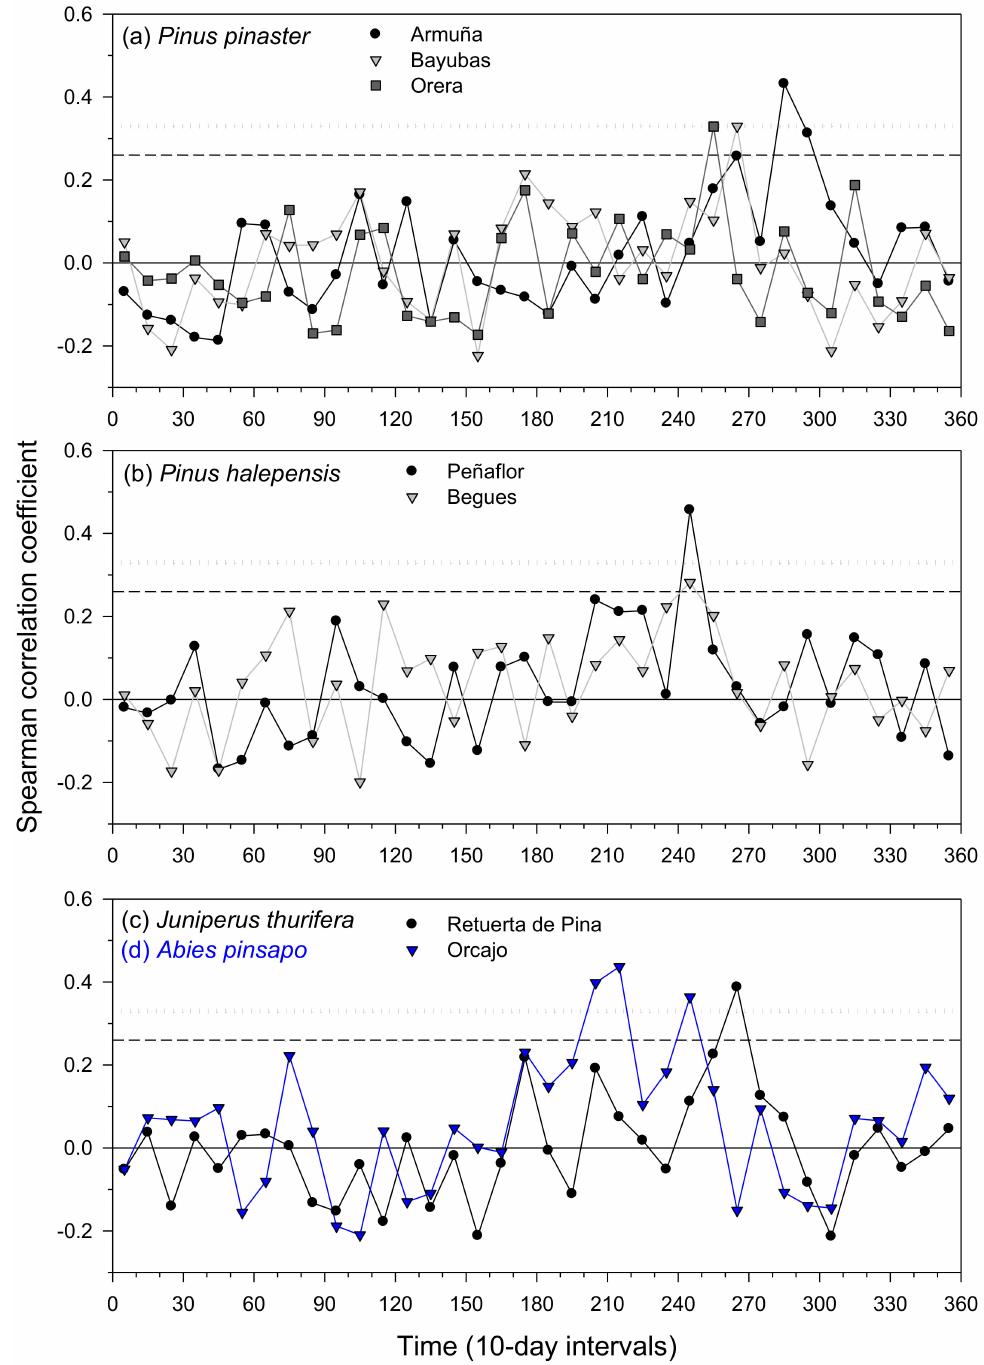
Figure 4. Summary of climate–IADF relationships calculated with 10-day long precipitation windows in the six study tree species (( a ), P. pinaster ; ( b ), P. halepensis ; ( c , d ), J. thurifera (black line and symbols), and A. pinsapo (blue line and symbols)). These correlations were only calculated in sites where there were meteorological stations with long-term (>30 years) precipitation records located less than 20 km away from sampled sites. Horizontal dashed and dotted lines show the 0.05 and 0.01 significance levels,